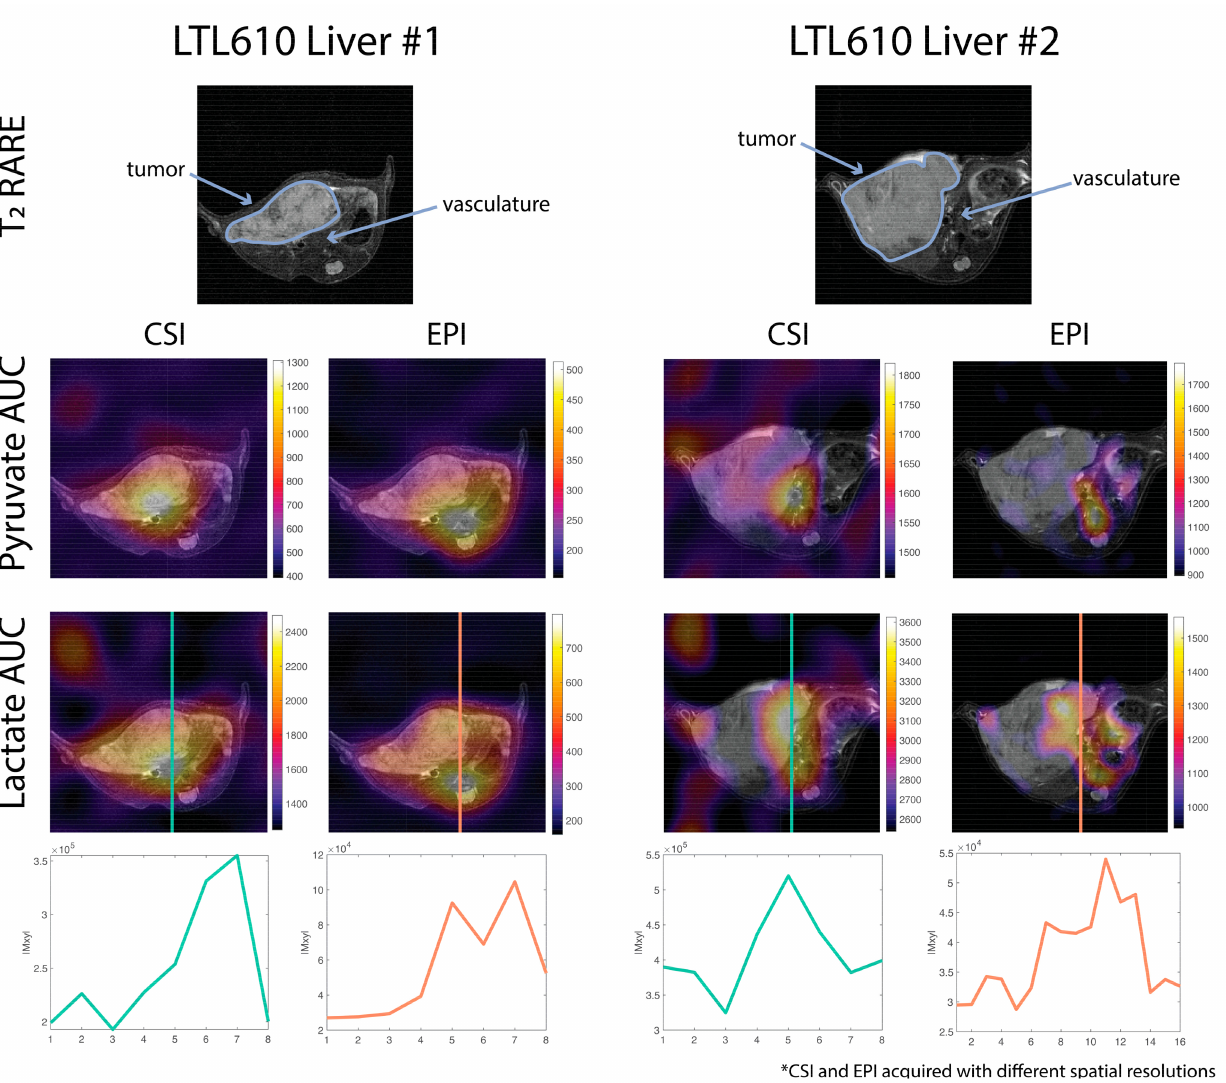
Figure 3. In vivo pyruvate and lactate area-under-the-curve (AUC) maps of two mice overlaid on T 2 RARE images. Both examples are of an LTL610 tumor implanted in the mouse liver. The EPI maps and lactate line profiles show two distinct signal peaks whereas the CSI maps have a single peak. The blurring of the vasculature signal due to the CSI PSF obscures lactate signal from the tumor. For both examples, CSI was acquired before EPI. See Figure S1 for dynamics of the CSI